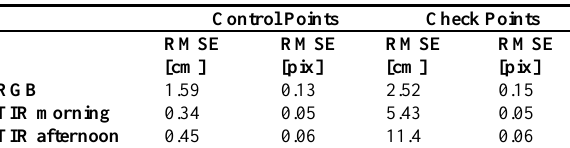
Table 2. Statistic values of the external orientation listed as